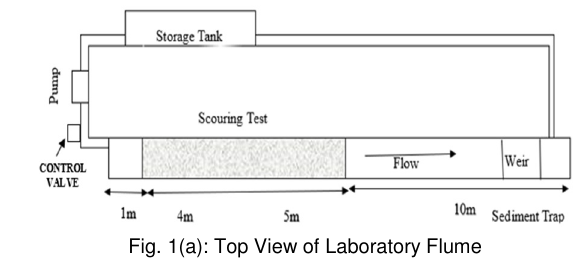
Fig. 1(a): Top View of Laboratory Flume